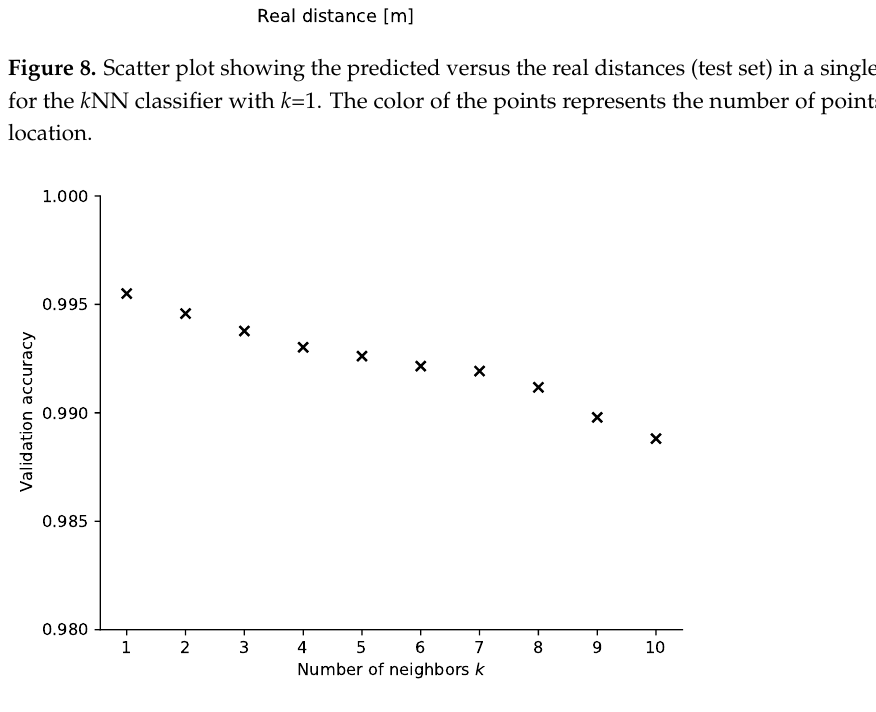
Figure 9. Mean accuracy of prediction achieved on the validation set for a varying number of neigbors in the k NN classifier. Table 2. Summary of classifier performance in the one-dimensional classification